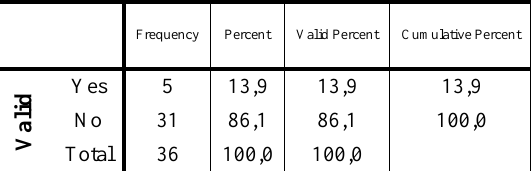
Table 8: Employees with Penalty Records in